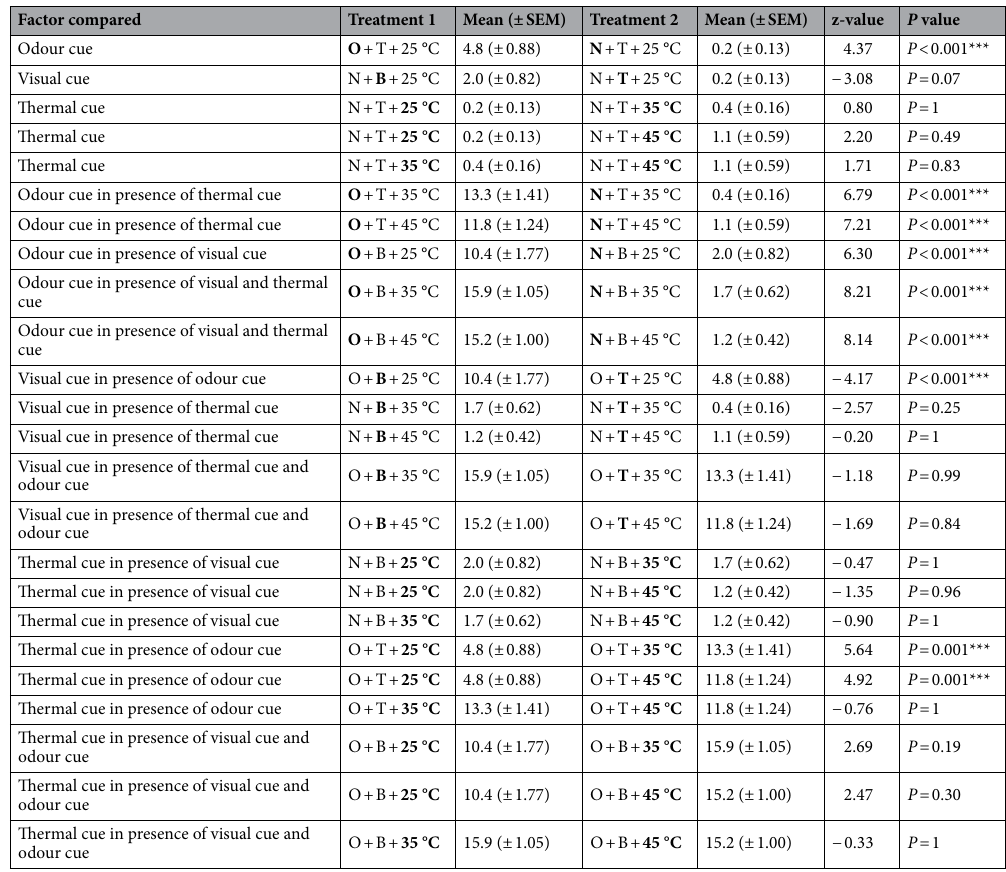
Table 1. Tukey contrast comparisons between mean landing rates for each permutation of possible treatment combinations. O Odour, N No odour, T transparent, B Black. In bold is highlighted the changing variable in each comparison. ***Denotes significant difference between the